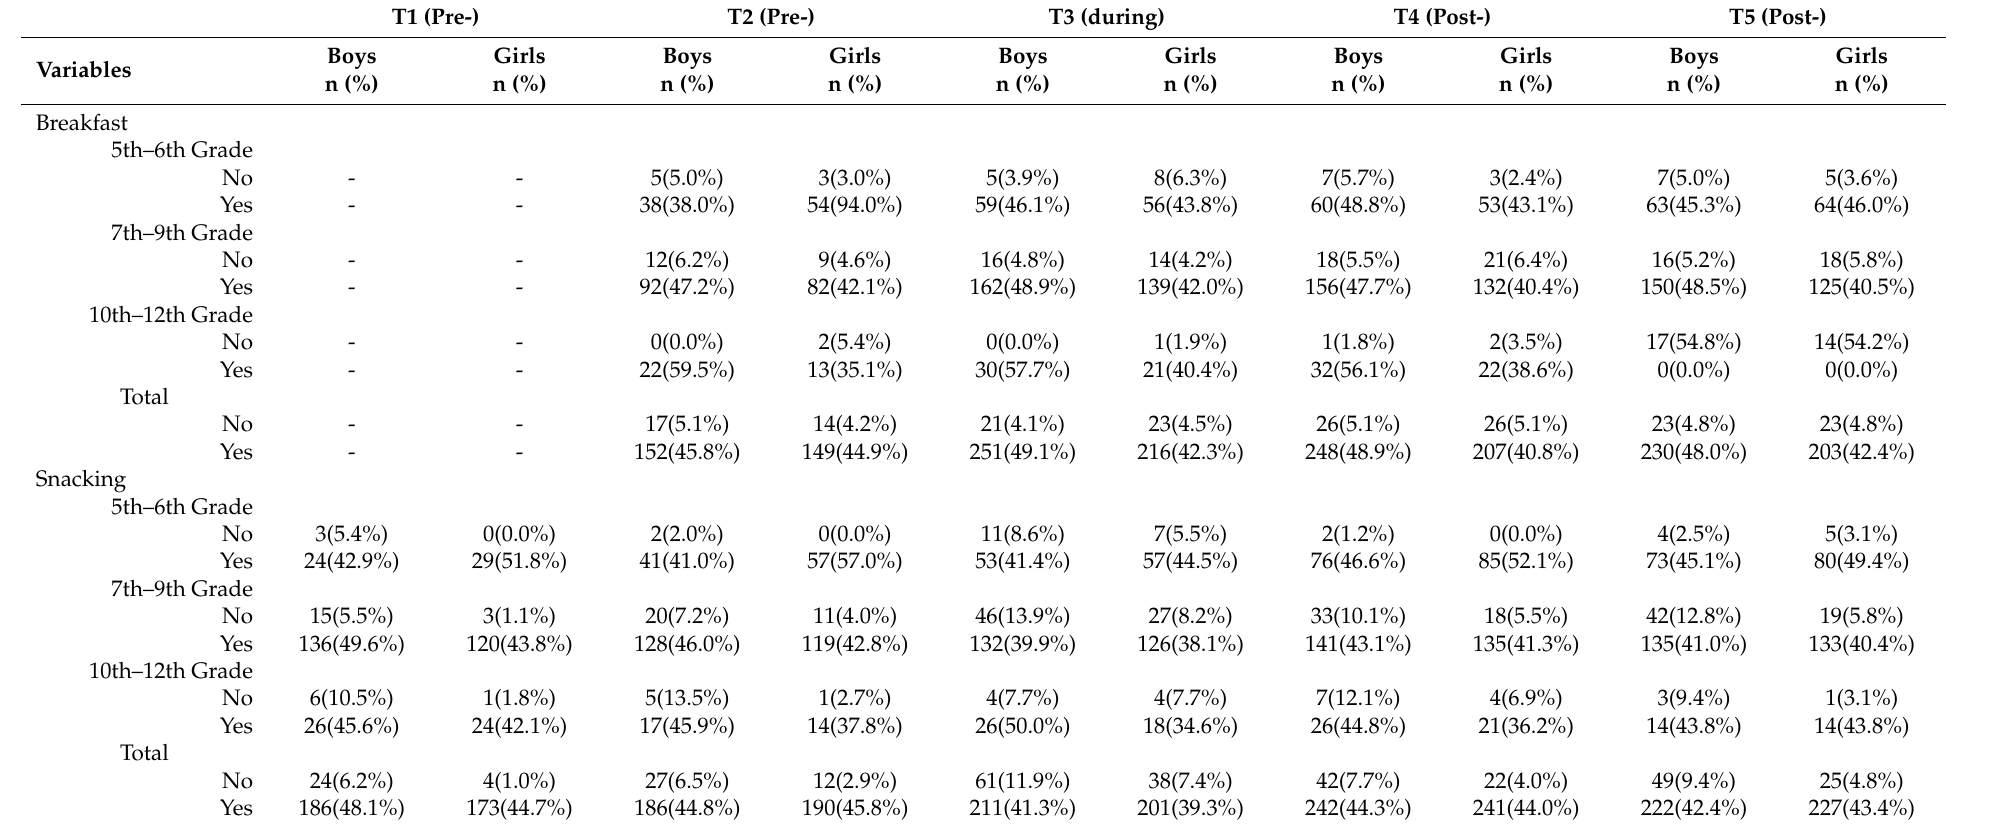
Table 2. Frequencies of the first goal—breakfast, snacking, and where the snack was acquired from